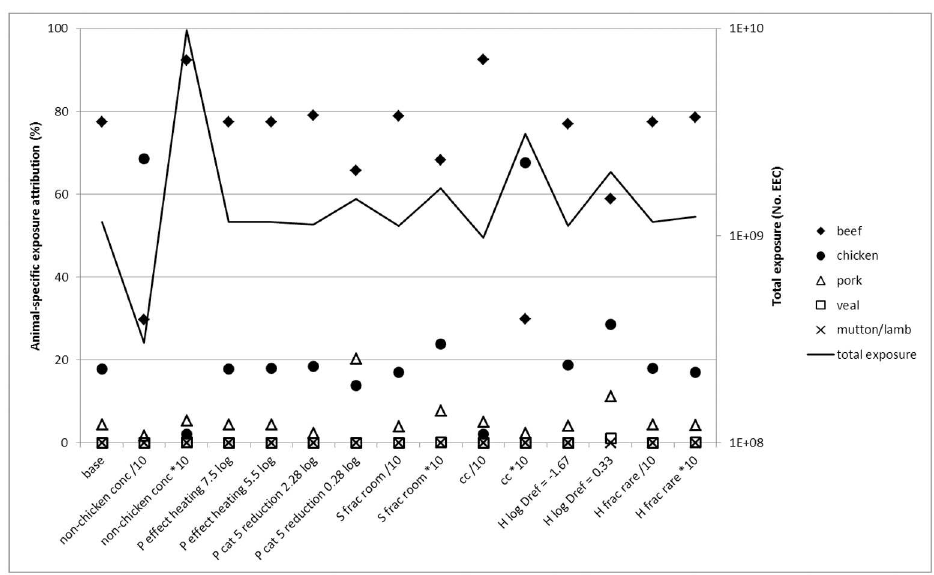
Fig 4. Sensitivity analysis results. Effect of 10-fold changesin parameter base values on total exposure (No. EEC) and food animal-specific attributionof exposure. P = preretail,S = storage, H = consumer heating, conc = concentration, cat = category, frac = fraction, cc =